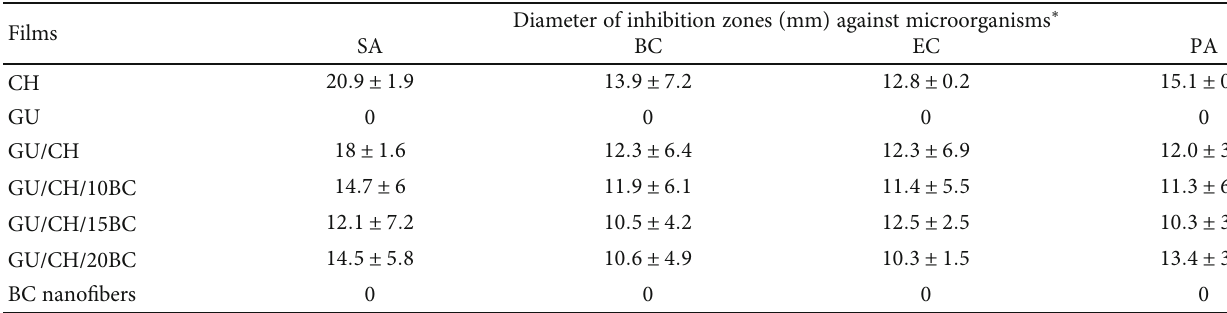
Figure 8: Tensile strength (a) and elongation at break (b) of each sample. Di ff erent letters a, b, c, d, and e in the vertical bar chart indicate signi fi cant di ff erences ( p ≤ 0 : 05 Table 3: Antibacterial activity of the fi lms.